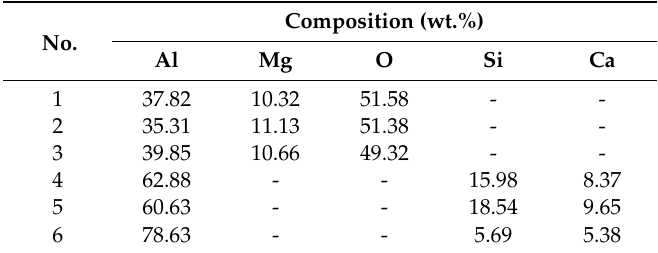
Figure 12. ( a ) Morphology of BF / Al, and element distribution: ( b ) Mg; ( c ) Al; ( d ) O; ( e ) Ca; ( f ) Si. Table 1. Compositions of different regions.